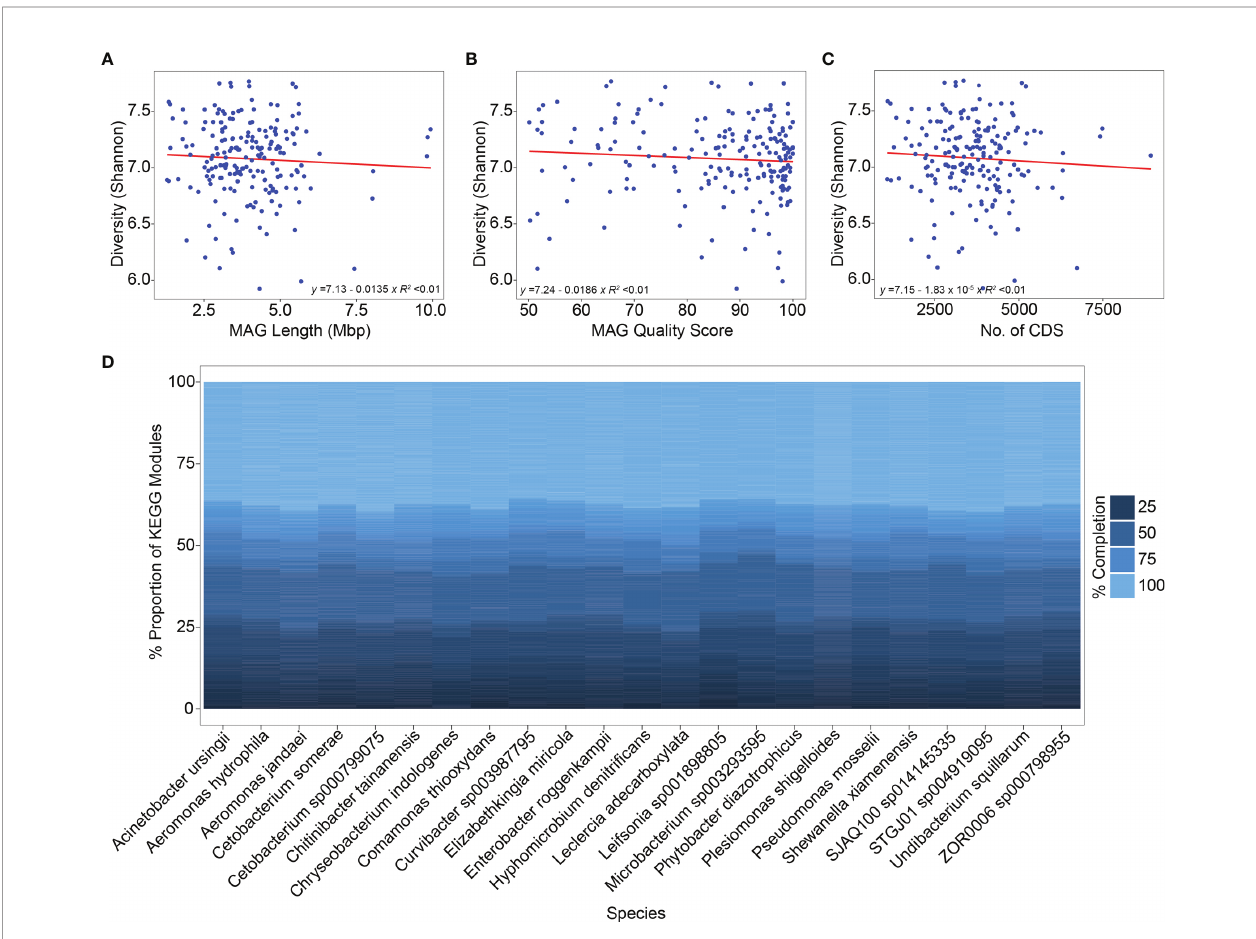
FIGURE 4 | Metabolic diversity-MAG characteristics ’ association and distribution of KEGG pathway modules in different species. (A – C) The correlation between metabolic diversity (inferred using the Shannon index), MAG Length, MAG quality score, and the number of predicted CDS is shown. Linear regression was performed to determine these correlations with the linear fi tting model. The results indicate no signi fi cant association between metabolic diversity and the three mentioned parameters ( R 2 < 0.01). (D) The relative proportion of different KEGG metabolic pathway modules is shown among the species that were successfully classi fi ed from the zebra fi sh stool MAGs. Nearly 40% of the metabolic pathway modules demonstrated a completion level of 100% whereas the remaining showed completion levels between